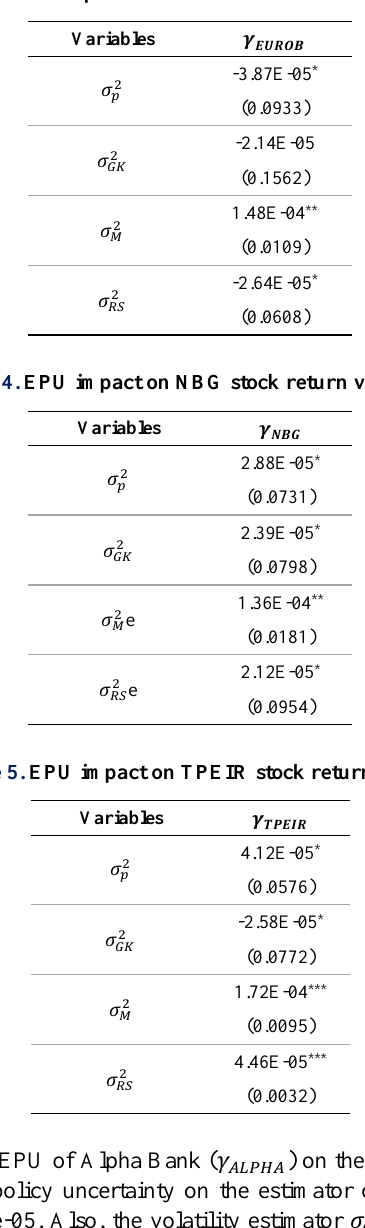
Table 3. EPU impact on EUROB stock return volatility